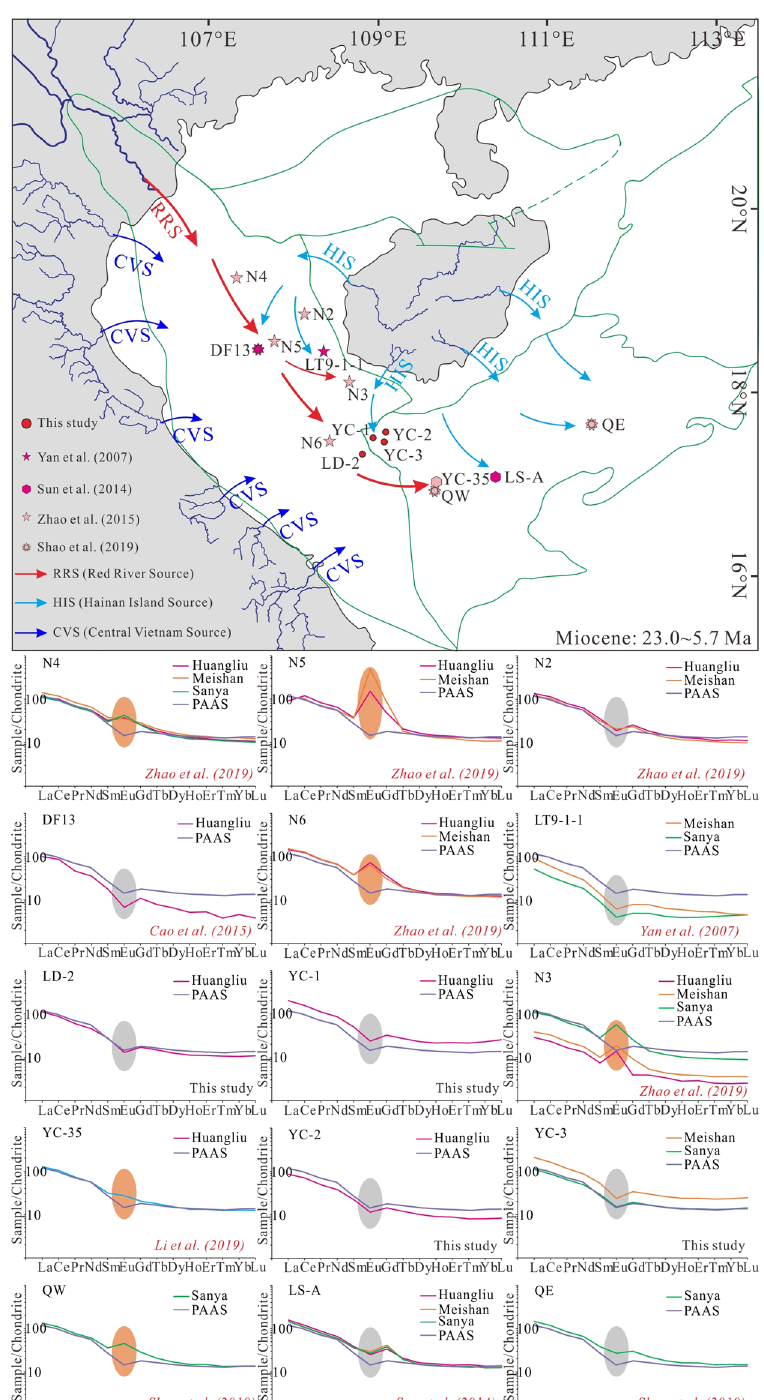
Figure 11. Schematic source-to-sink evolution model and chondrite 50 normalized REEpatterns of Miocene samples from the Yinggehai and Qiongdongnan